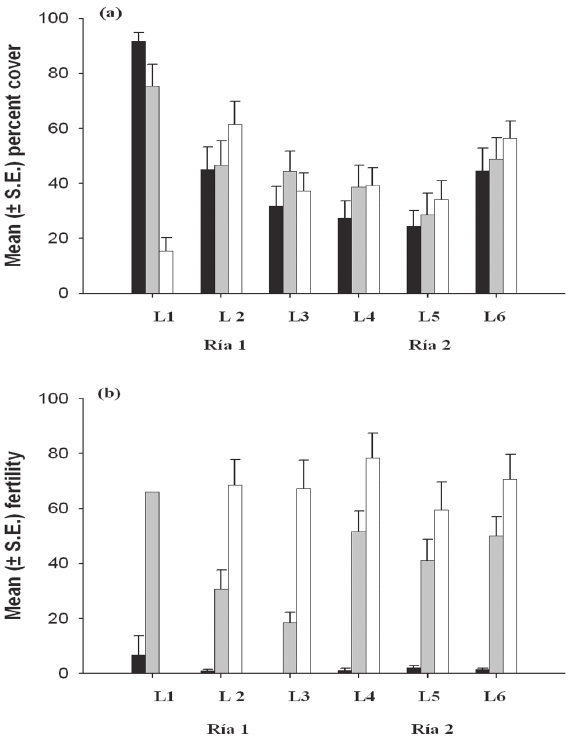
Fig . 2. – temporal variation of phenological variables at ‘location’ scale (n = 20). Mean (± s.e.) of (a) percent cover and (b) fertility at each of the 3 locations (l1-l6) within the two rias (ría de vigo and ría de aldán). black, grey and white bars represent March, april and July,